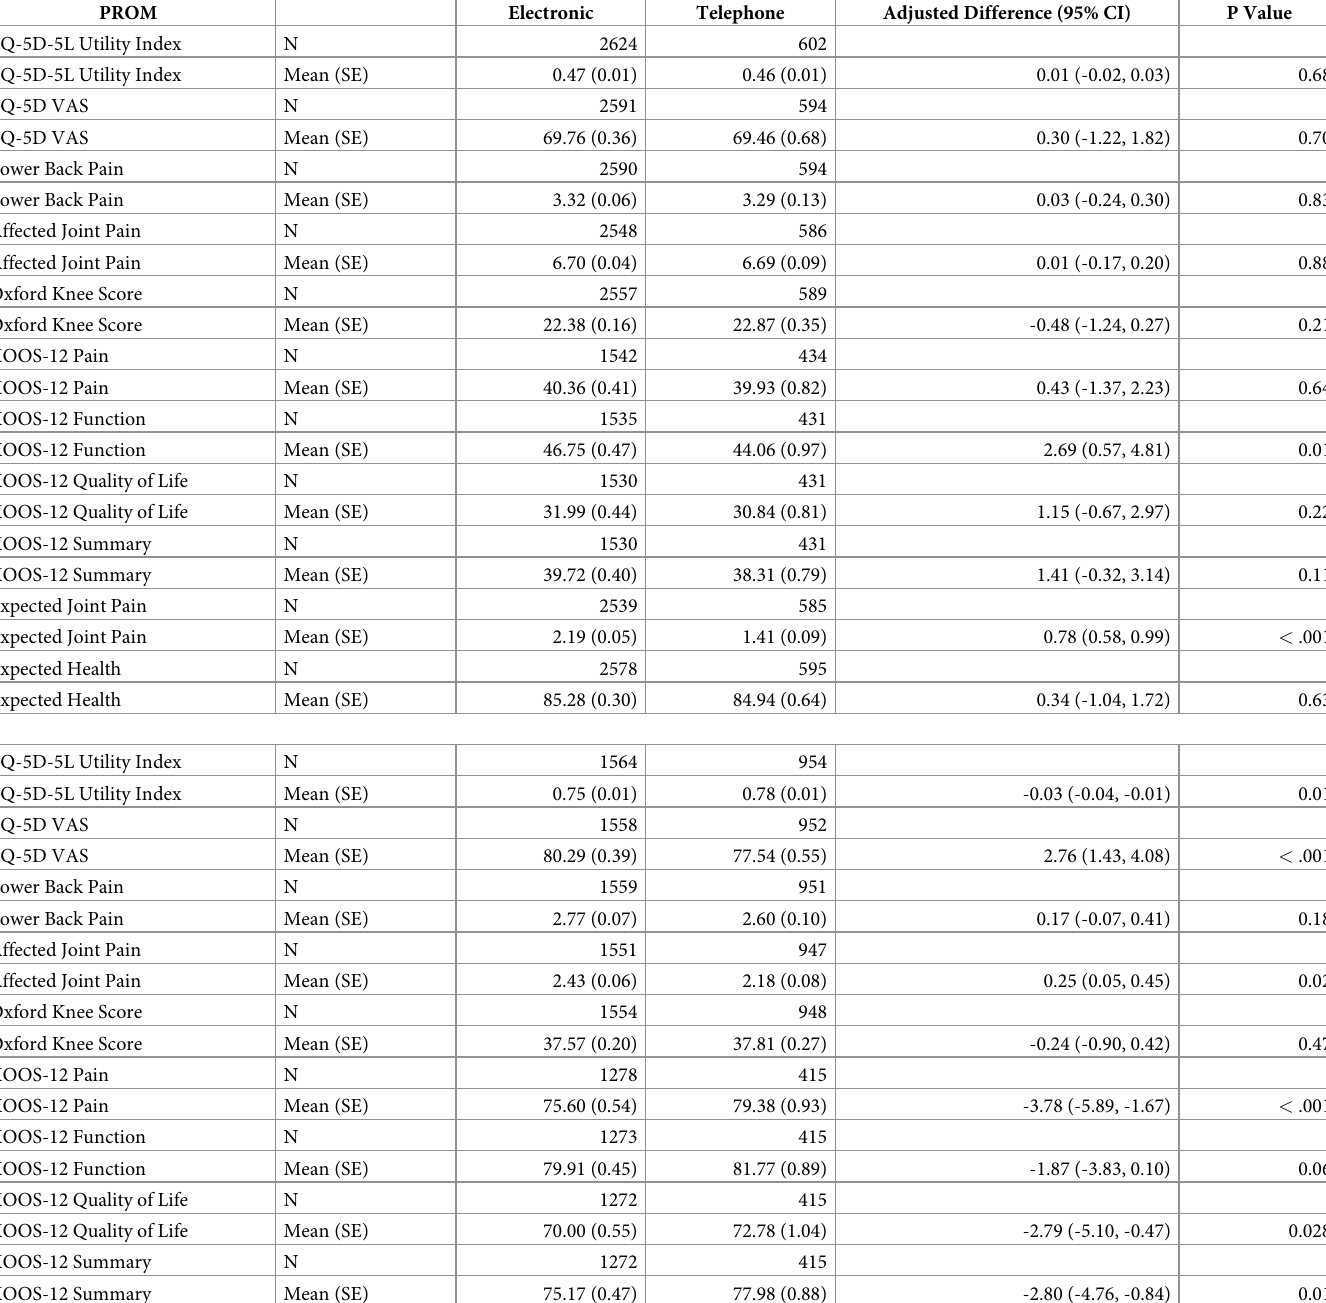
Table 5. a: Pre-operative patient-reported outcomes comparing patients responding directly (“electronic”) and those responding by telephone (“telephone”) for patients undergoing TKA. b: Post-operative patient-reported outcomes comparing patients responding directly (“electronic”) and those responding by telephone (“telephone”) for patients undergoing